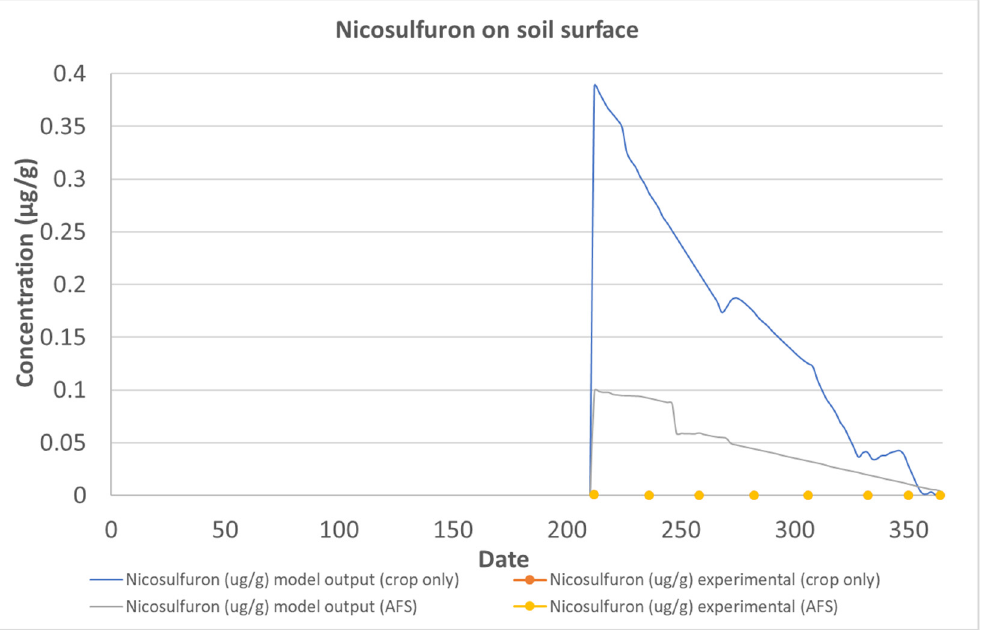
Figure 5. Comparison of nicosulfuron concentrations in the top soil layer (0–5 cm) between maize- only and maize-olive systems (Application: Day 210).